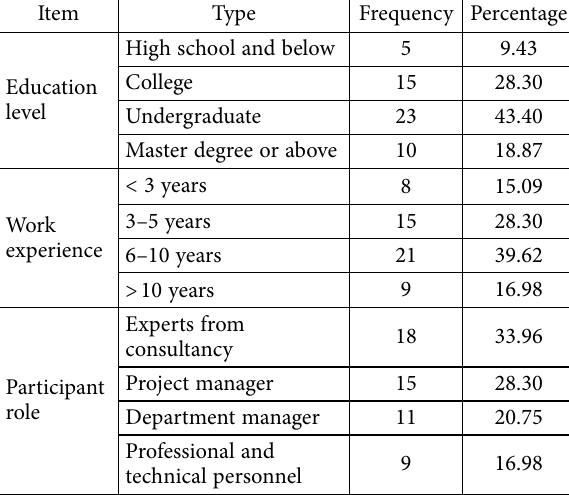
Table 2. Respondent characteristics